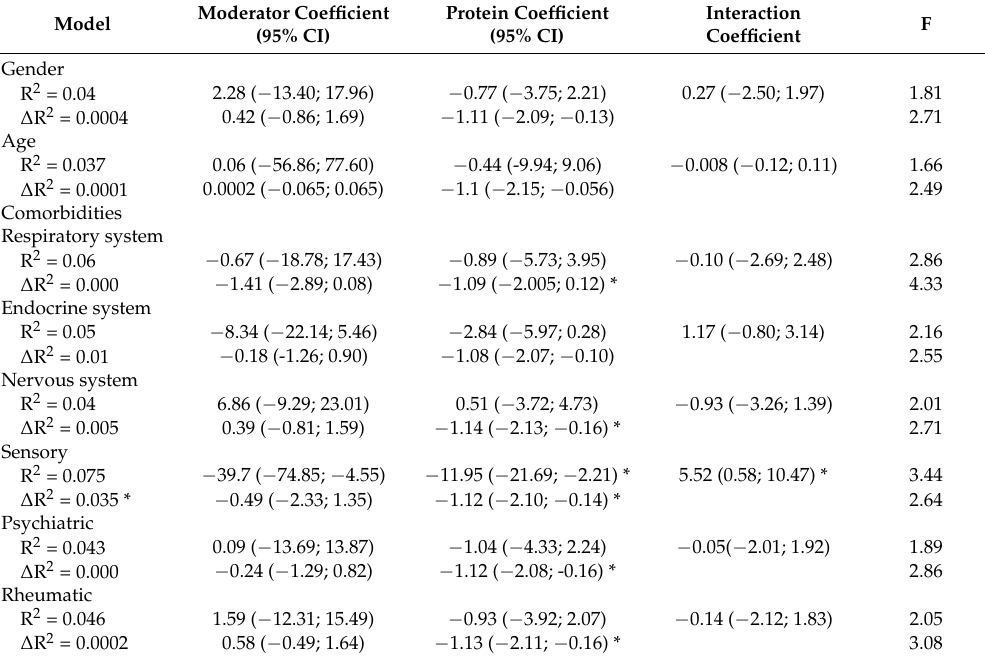
Table 3. Moderation effect tested for the correlation between depression and protein